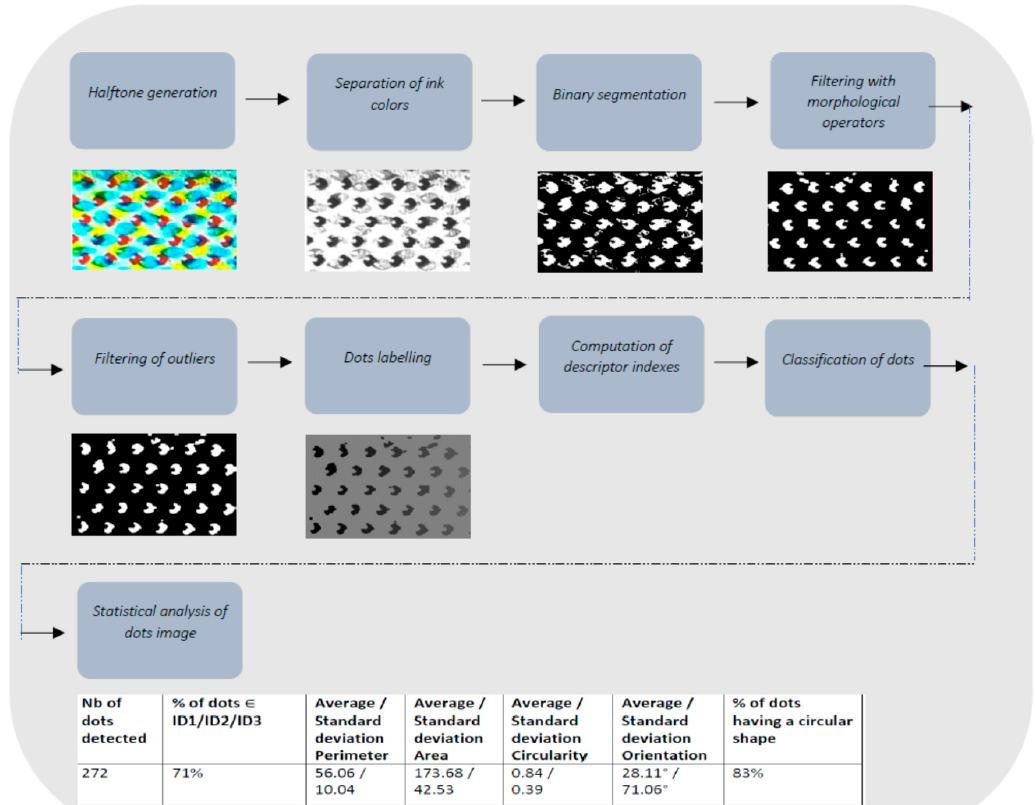
Figure 3. Framework of the proposed image processing pipeline.